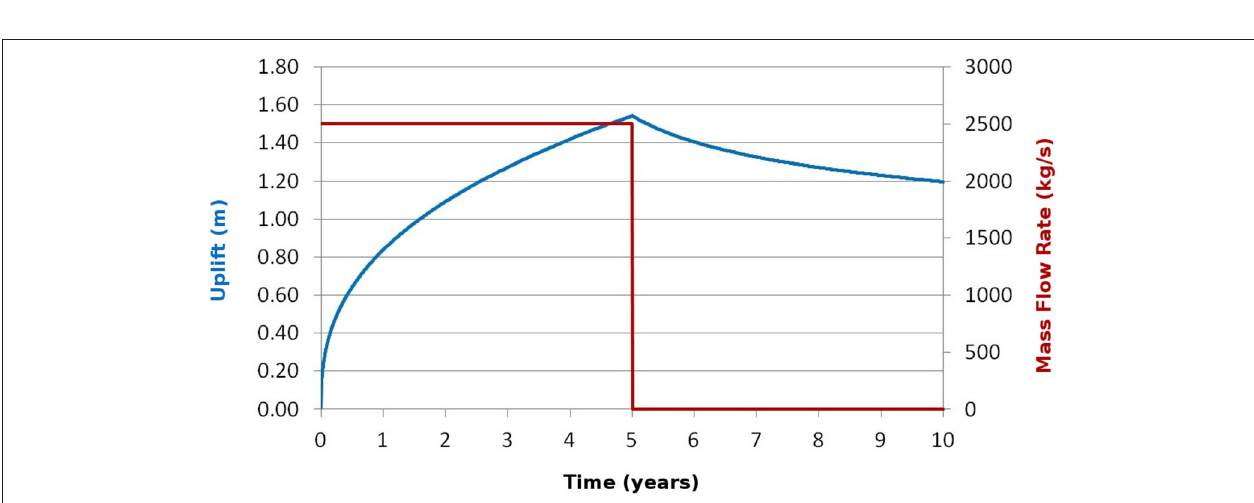
FIGURE 4 | Plot of the uplift (blue line, left axis) over time of the center of the sill. The red line represents the mass flow rate (right axis) of magma filling the sill over time. Note that the rate of the uplift decreases even for a constant mass flow rate (2,500